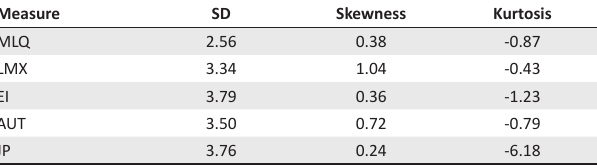
TABLE 2: Skewness and kurtosis of the variables. Measure SD